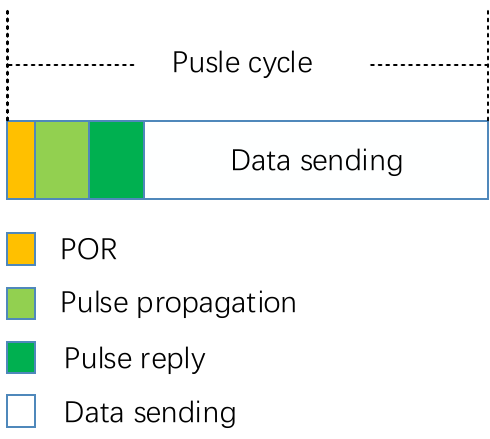
Figure 3. Schematic diagram of pulse